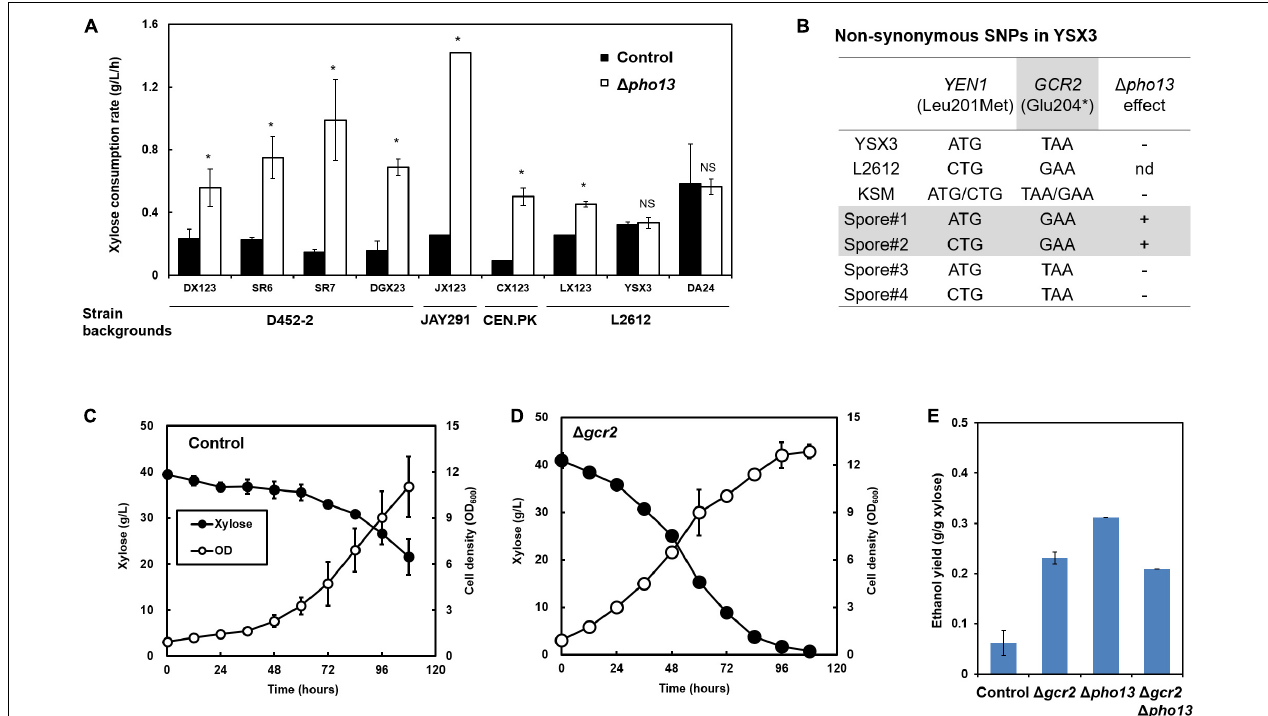
FIGURE 1 | Loss-of-function mutation in GCR2 is responsible for the (cid:49) pho13 -negative phenotype in xylose-fermenting S. cerevisiae strains. (A) Improved xylose consumption rates by the deletion of PHO13 ( (cid:49) pho13 ) in engineered strains with different strain backgrounds, except for YSX3 and DA24 strains. (B) Genome sequencing results of the YSX3 and L2612 strains and Sanger sequencing results of haploid spores derived from the KSM diploid (YSX3 × a derivative of D452-2). (C–E) Xylose fermentation profiles by the SR7 strain (control) and its gene deletion mutants ( (cid:49) gcr2 , (cid:49) pho13 , and (cid:49) gcr2 / (cid:49) pho13 ). Fermentation was performed with an initial cell density of 0.5 g/L in YP medium containing 40 g/L xylose under microaerobic conditions. * p < 0.05; NS, not statistically significant; nd, not determined.